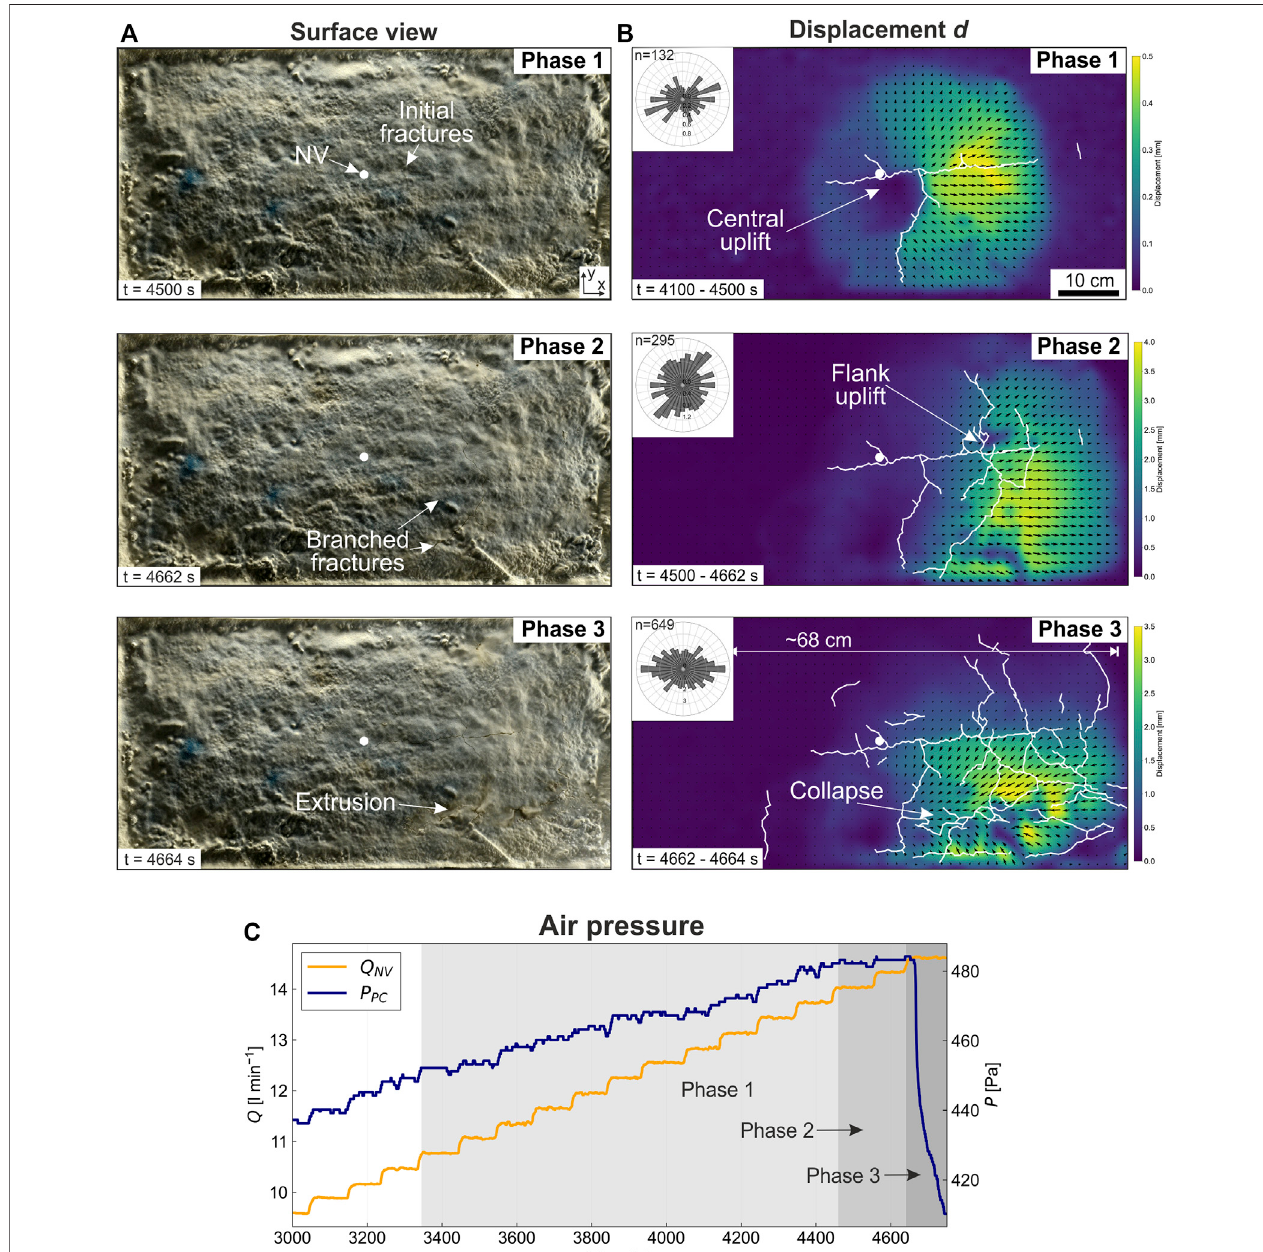
FIGURE 7 | Results of exp.2B, which consisted of a multi-layered cover and was performed in the 3D con fi guration of the apparatus. (A) Top view of the experimentalsurface.Phase1:initialfracturesandaforcedfoldformed inthecentreofthebox.Phase2:branchedfracturesandupliftofthe fl ankdevelopeddominantly in the right half of the box. Phase 3: Rapid collapse of the force fold occurred and was associated with the formation of collapse fractures. (B) Displacement vector fi eld derived from the DIC analysis. The background color displays the amount of the total displacement. Each image shows the cumulative displacement for the speci fi ed time interval. The rose diagrams show the strike directions normalized by the lengths of individual fracture segments (white lines). (C) Time series of the air fl ux throughtheneedlevalve( Q NV )and thepressureinthe pressurechamber( P PC ).Air fl ux atthebase ofthepressurechamber( Q PC )wasconstantsothat P PC wasapprox. 40% of the total vertical normal stress at the beginning of the experiment ( Table 1 ).